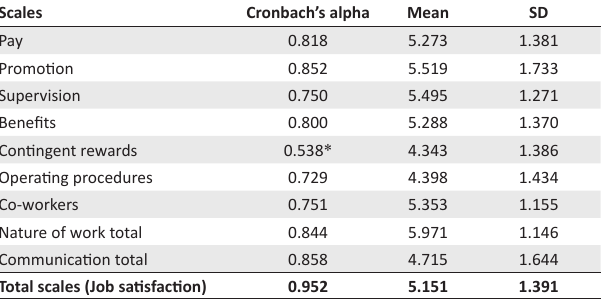
TABLE 2: Frequency distribution for job satisfaction survey. Scales